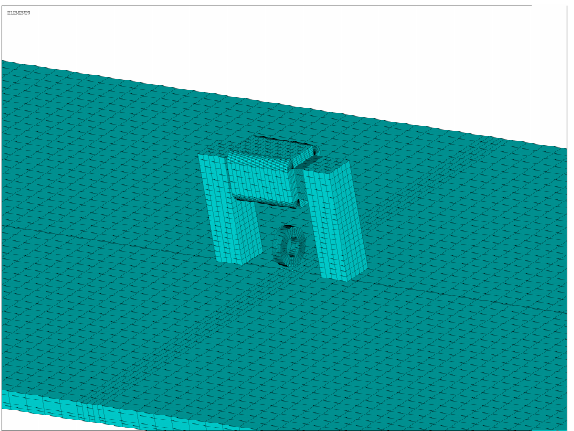
Figure 5. Three-dimensional simulation model grid division details.